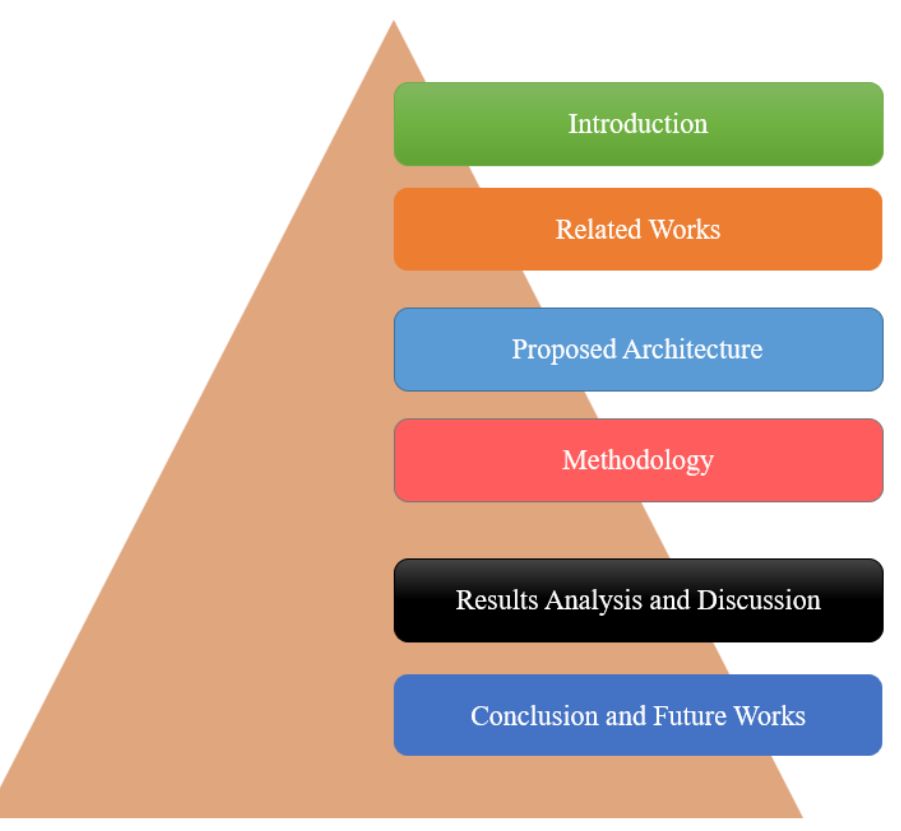
Figure 1. Outline of this